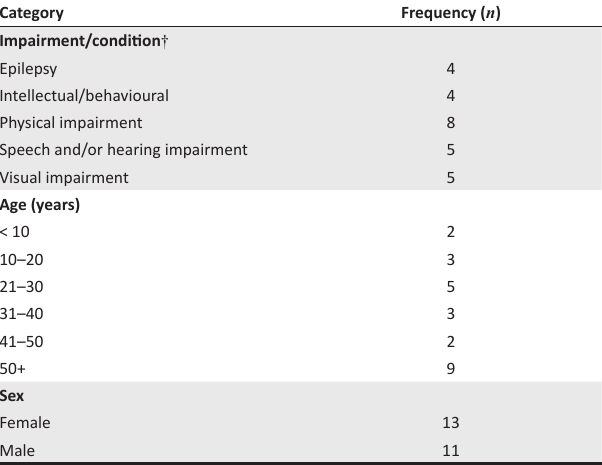
TABLE 1: Demographics of participants with disabilities by impairment category † , age and sex.